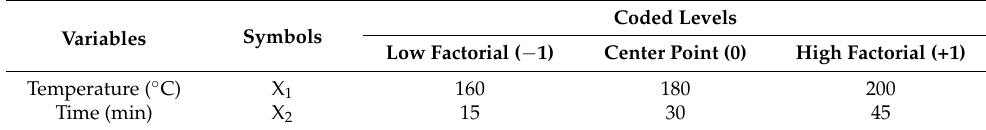
Table 15. Independent variables used for response surface